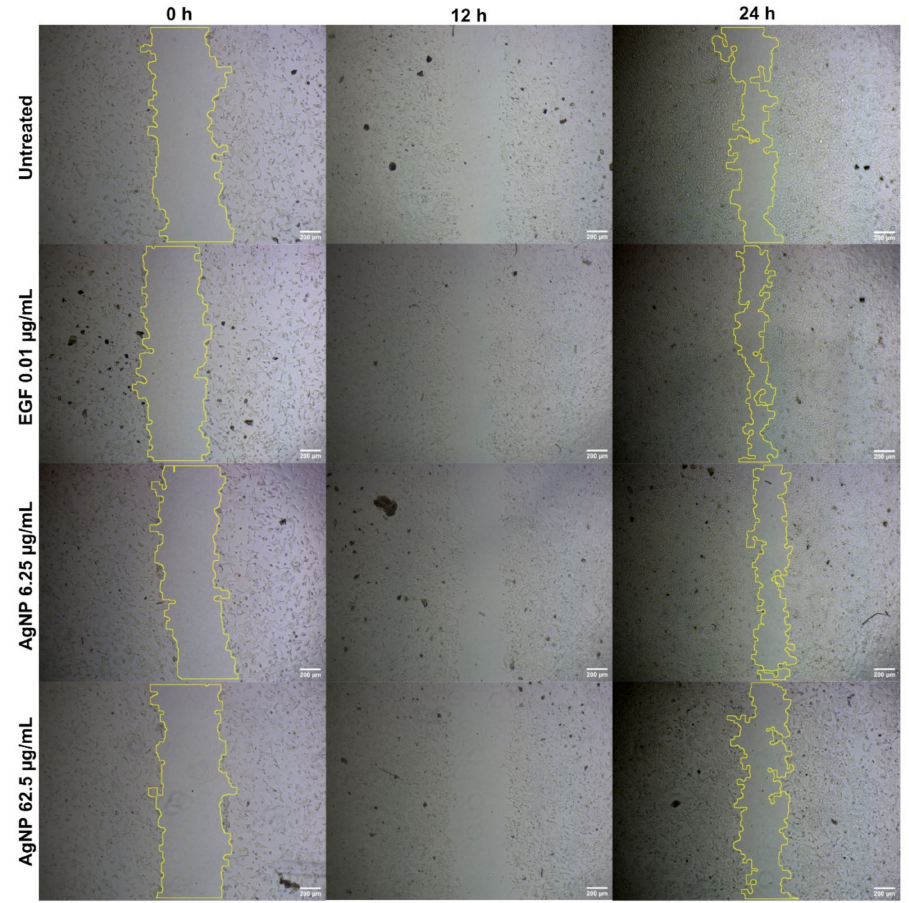
Figure 4. Cellular migration in V79 Chinese hamster lung fibroblast cells analyzed through scratch assay for wound-healing properties of AgNPs at different